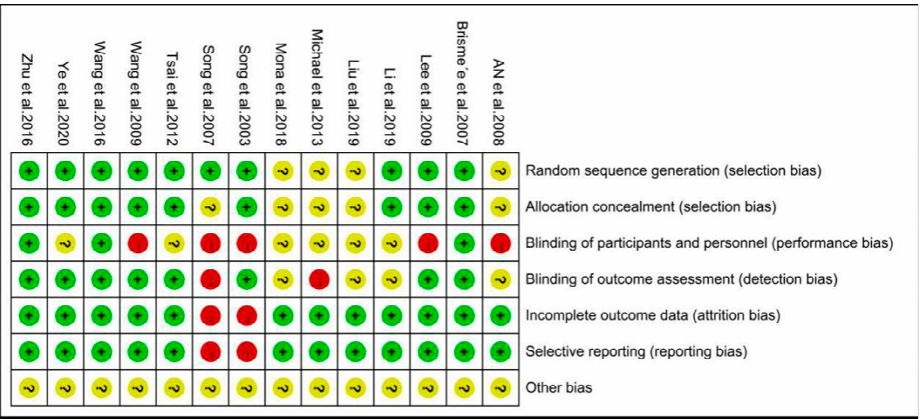
Figure 3. Risk of bias summary.